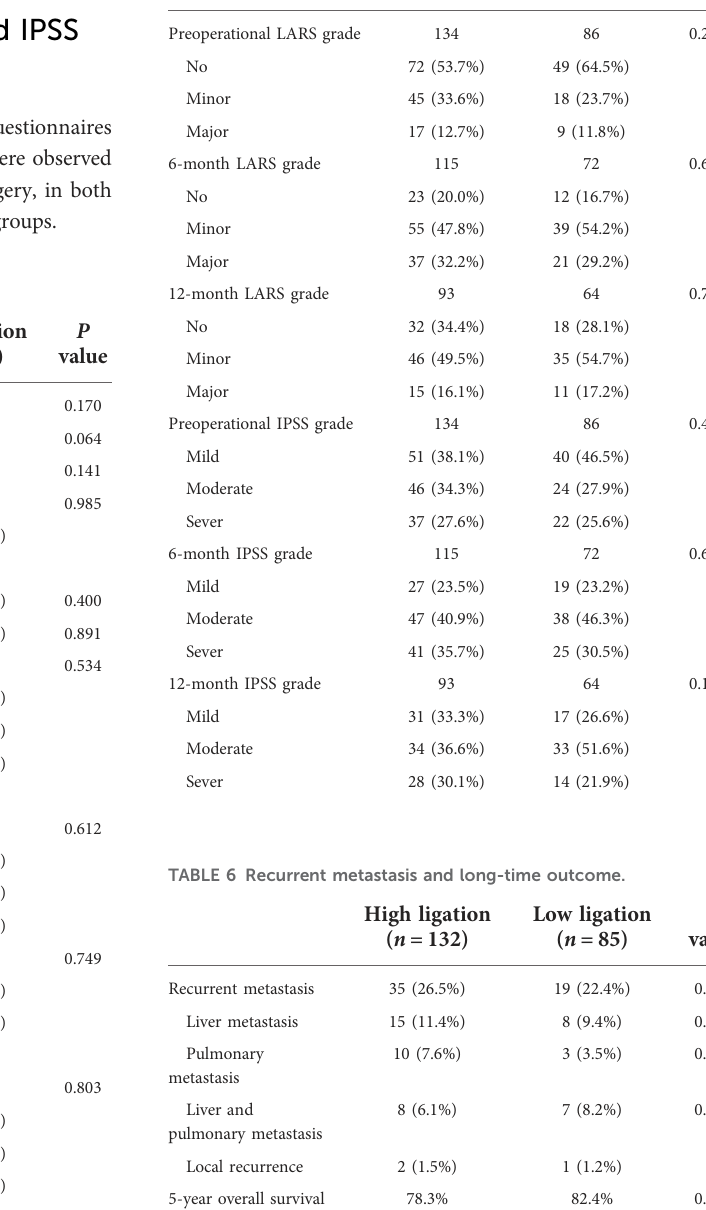
TABLE 5 Function outcomes of LARS and IPSS.